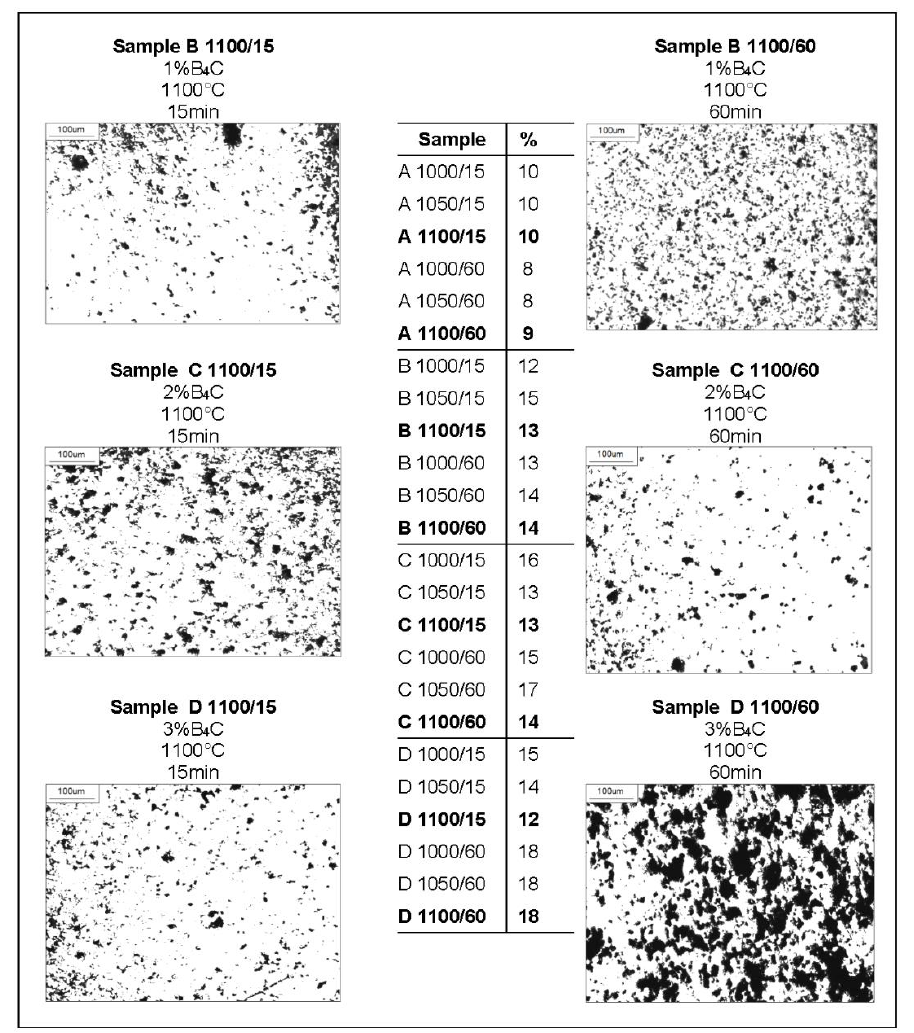
Table 5. Percentage of porosity in the sintered